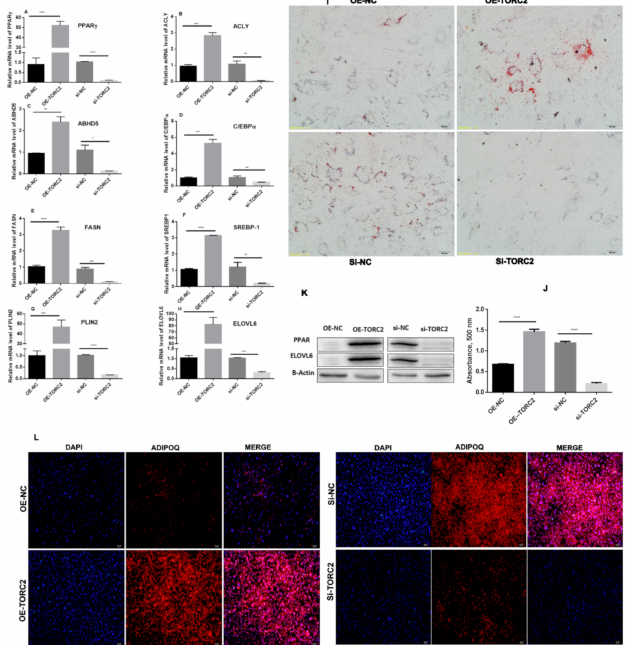
Figure 3. TORC2 promotes bovine adipocyte di ff erentiation. ( A – H ) Expression level of genes related to adipocyte di ff erentiation. Relative levels of mRNA of PPAR γ , ACLY , ABHD5 , CEBP α , FASN , SREBP-1 , PLIN2 , and ELOVL6 were measured by qRT-PCR. ( K ) The protein levels of PPAR γ , ELOVL6 with reference protein β -ACTIN was measured through Western blotting. ( I , J ) Oil red O staining of bovine adipocyte cells at day 9 of di ff erentiation transfected with OE-NC, OE-TORC2, siNC, or siTORC2. ( L ) Immunofluorescence of Adiponectin was performed at day 9 of di ff erentiation of cells transfected with OE-NC, OE-TORC2, siNC, or siTORC2. The values represent the mean ± SEM ( n = 3). * p < 0.05; ** p < 0.01; and *** p <